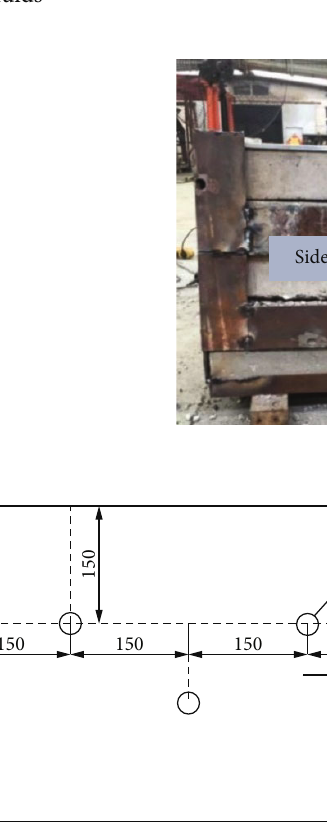
Figure 4: Drilling